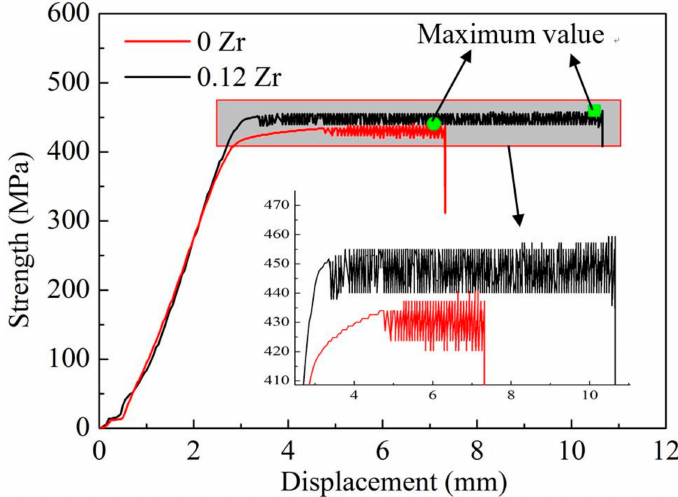
Figure 5. Tensile curves of 1.2 mm Al-5Mg and Al-5Mg-0.12Zr wire